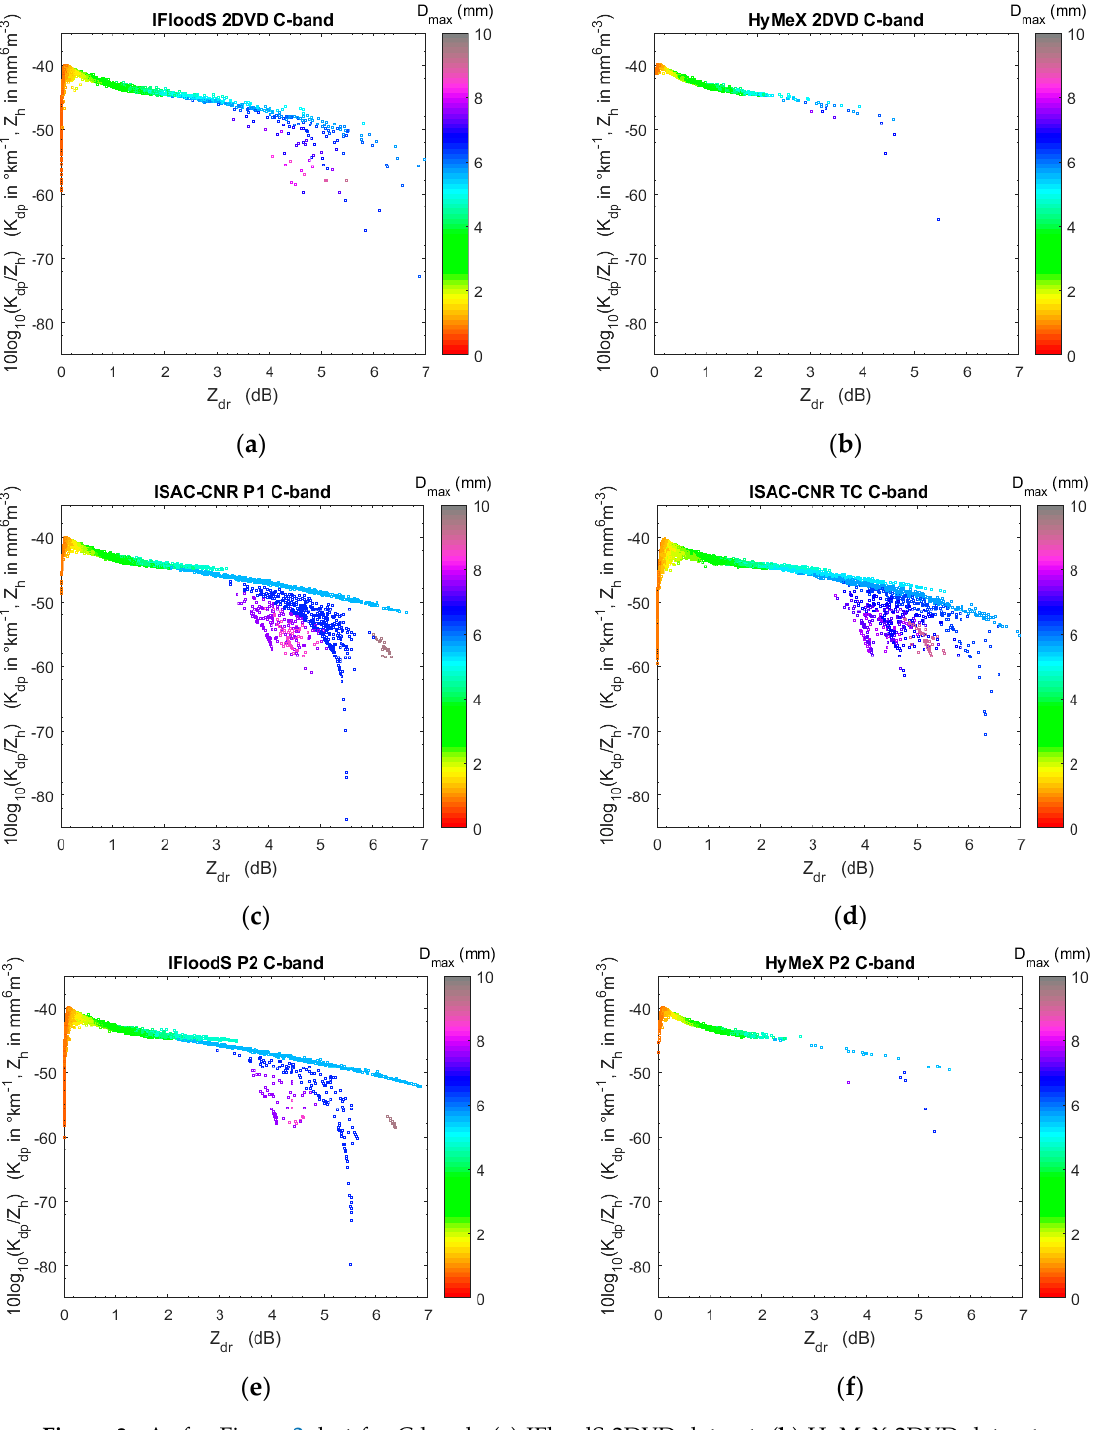
Figure 3. As for Figure 2, but for C-band. ( a ) IFloodS 2DVD dataset; ( b ) HyMeX 2DVD dataset; ( c )